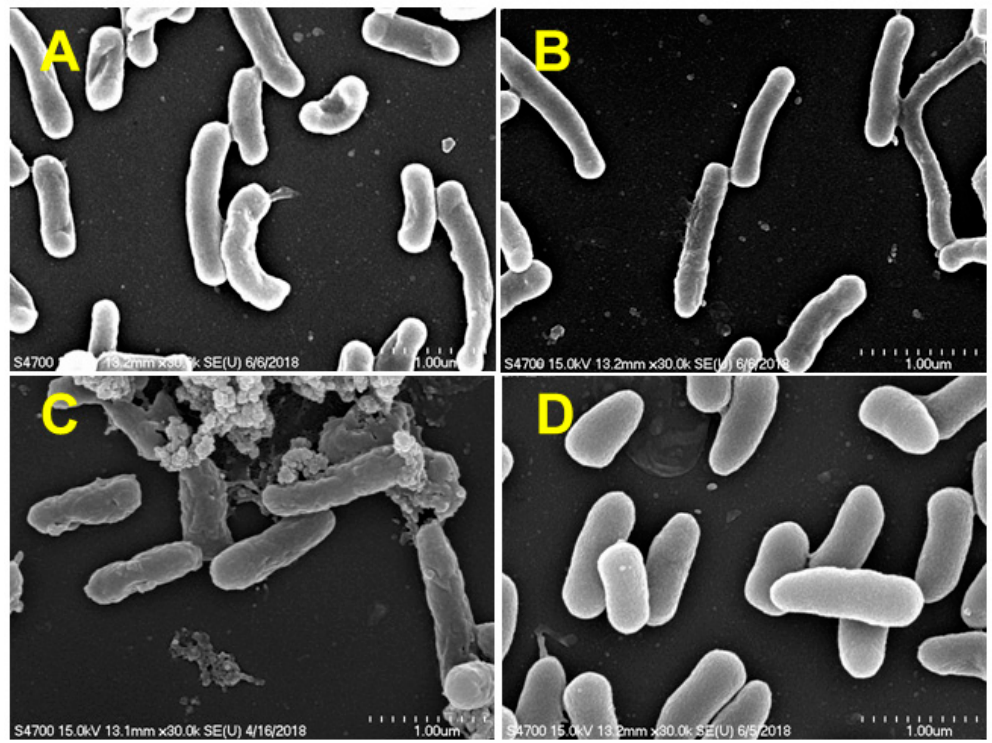
Figure 6. Photo pictures of isolated SMX-degrading bacteria by scan electron microscopy. ( A ) Bacteria strain A2. ( B ) Bacteria strain A12. ( C ) Bacteria strain L. ( D ) Bacteria strain M.